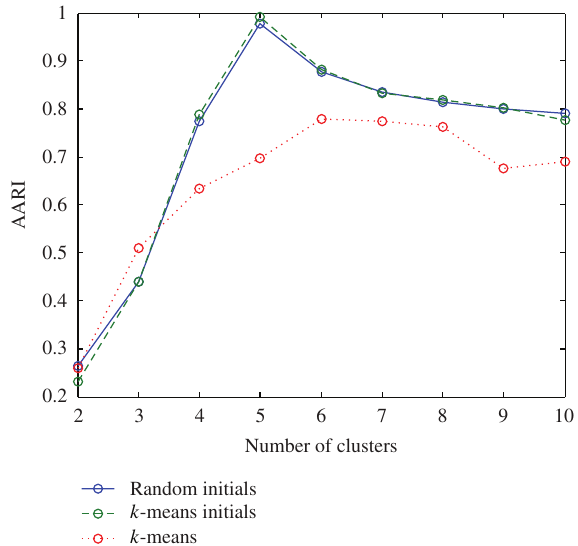
FIGURE 1: Plot of ARRI over different number of clusters for synthetic dataset.